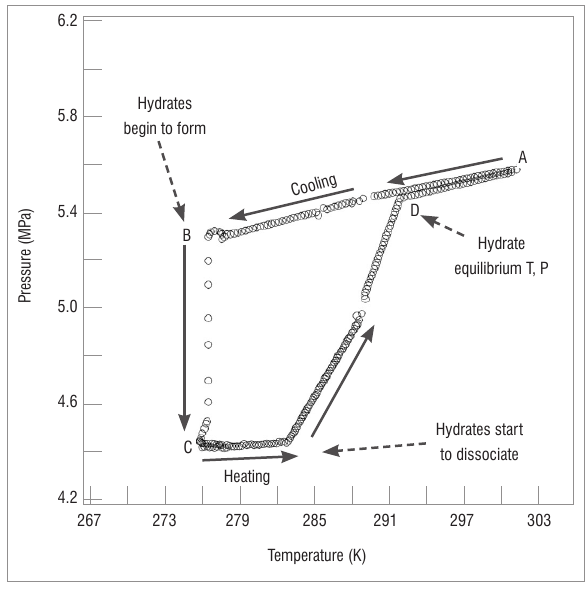
Figure 11: Pressure–temperature diagram for formation and dissociation of hydrates via the isochoric pressure-search method. 38